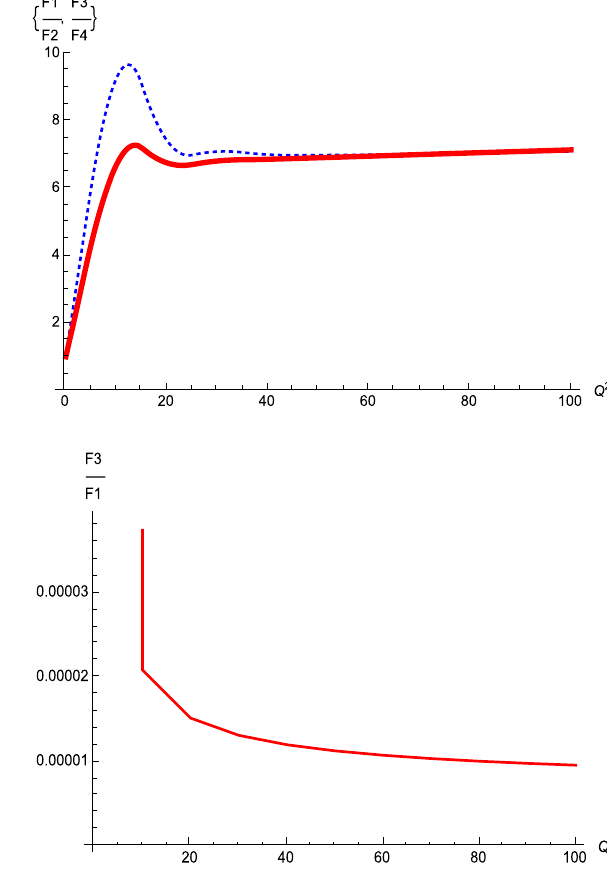
Fig. 17 Upper panel: Dotted curve is the ratio of the form factors F ( Q 2 ) for the normal ground state No. 1 and for the normal excited stateNo.2.SolidcurveisthesamefortheabnormalstatesNo.3andNo. 4. Lower panel: The ratio of the form factors F ( Q 2 ) for the abnormal state No. 3 from Table 1 and the normal one No.